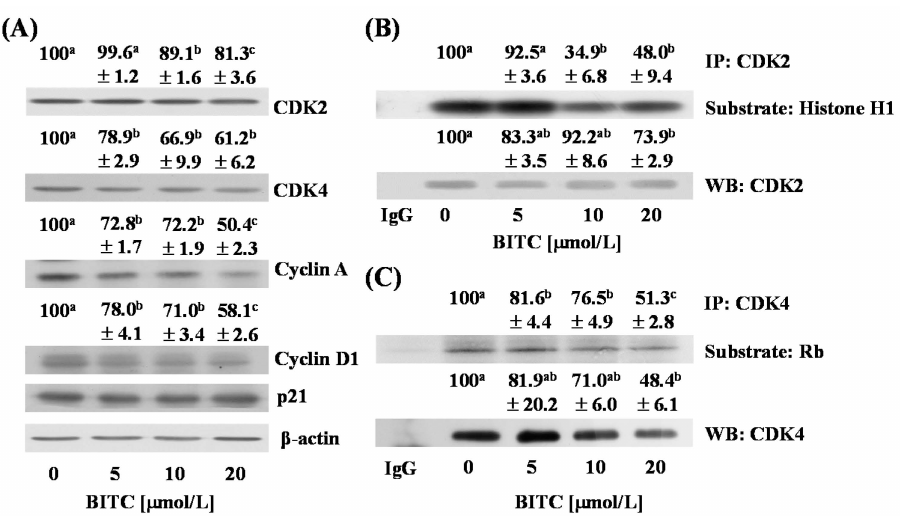
Figure 4. BITC reduces the expression of cyclin A and cyclin D1 and inhibits the activity of CDK2 and CDK4 in TRAMP-C2 mouse prostate cancer cells. Cells were plated in 100 mm dishes at 1 ˆ 10 6 cells/dish. Twenty-four h after plating, the monolayers were serum-deprived in serum-deprivation medium for 6 h. Cells were then incubated for 3 h with serum-deprivation medium containing various concentrations of BITC (0, 5, 10, or 20 µ mol/L); ( A ) The expression of CDK2, CDK4, cyclin A, and cyclin D1 were estimated by immunoblotting. The relative intensity of each band (normalized with its own β -actin) is shown above each band; ( B , C ) Cell lysates were incubated with an anti-CDK2 ( B ) or an anti-CDK4 ( C ) antibody and the immune complexes were precipitated with protein A sepharose. For the in vitro kinase assay, immunoprecipitated proteins were incubated with a substrate ( B : Histone H1, C : retinoblastoma protein (Rb)) and [ γ - 32 P]ATP. Each sample was subjected to SDS-PAGE and the gel was dried. The bands were visualized by autoradiography. For Western blot analysis, immunoprecipitated proteins were analyzed by Western blotting with an anti-CDK2 ( B ) or an anti-CDK4 ( C ) antibody. The relative intensity of each band was quantified and the control (0 µ mol/L BITC) levels were set at 100%. Data denotes the mean ˘ SEM ( n = 3). Means without a common letter differ, p <